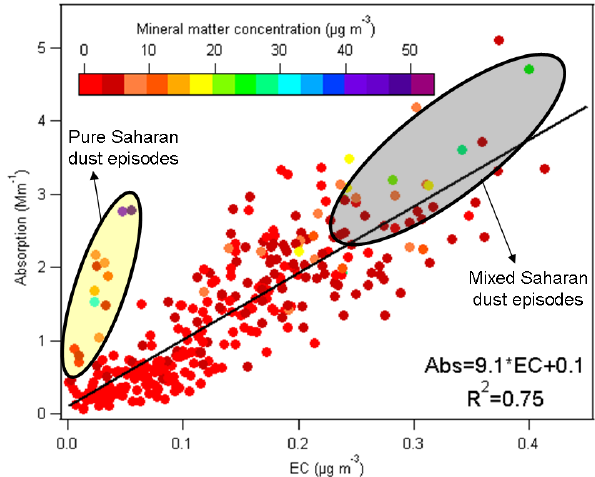
Fig. 7. Measured absorption versus PM 10 elemental carbon (EC) concentration as a function of PM 10 mineral matter concentration during the study period at Montsec. Data points correspond to daily